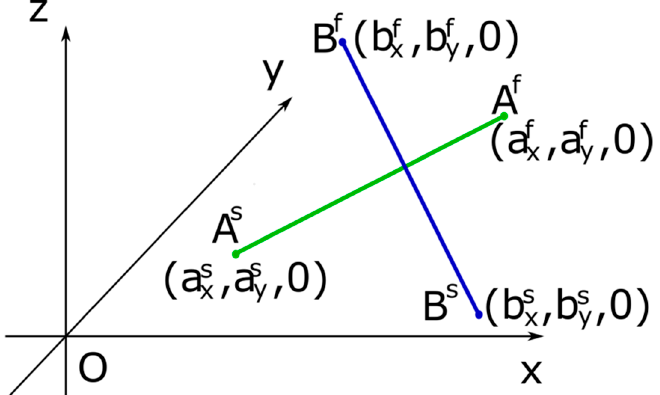
Figure 5. Schematics of the intersecting segments A s A f and B s B f for explaining the intersection conditions given by Equations (1)–(3).